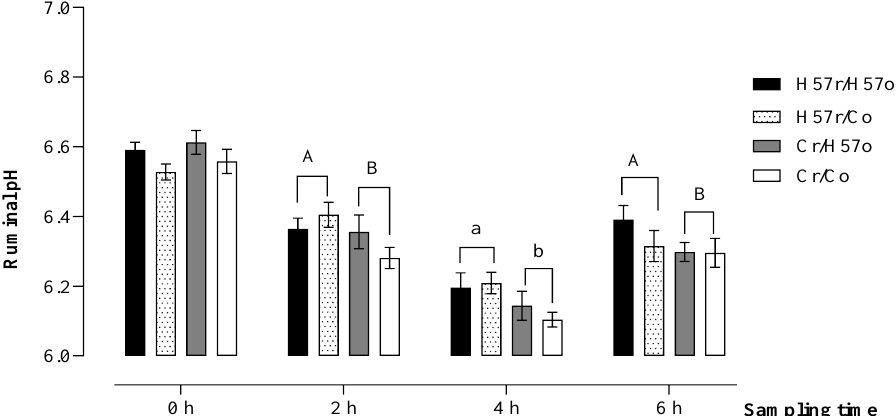
Figure 3. Ruminal pH following the addition of H57 or C pellets into the digestive system, either orally (o) or through a rumen fistula (r). A, B Values indicate a tendency towards statistical significance at p < 0.10; a, b values differ at p < 0.05; the p -value indicates the comparison between H57 (H57r/H57o and H57r/Co) and C (Cr/H57o and Cr/Co) pellets introduced directly into the rumen regardless of what was eaten from the troughs; error bars represent s.e.m.